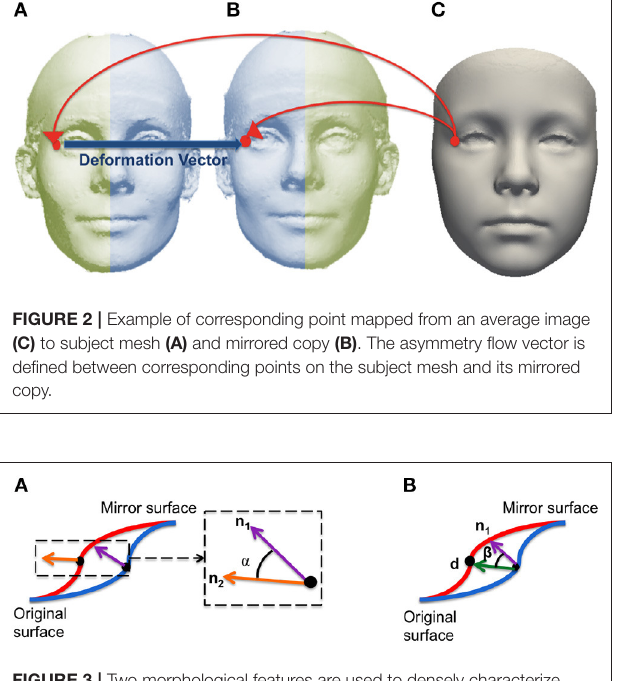
FIGURE 3 | Two morphological features are used to densely characterize facial symmetry and averageness: (A) angle of surface orientation and (B) angle of